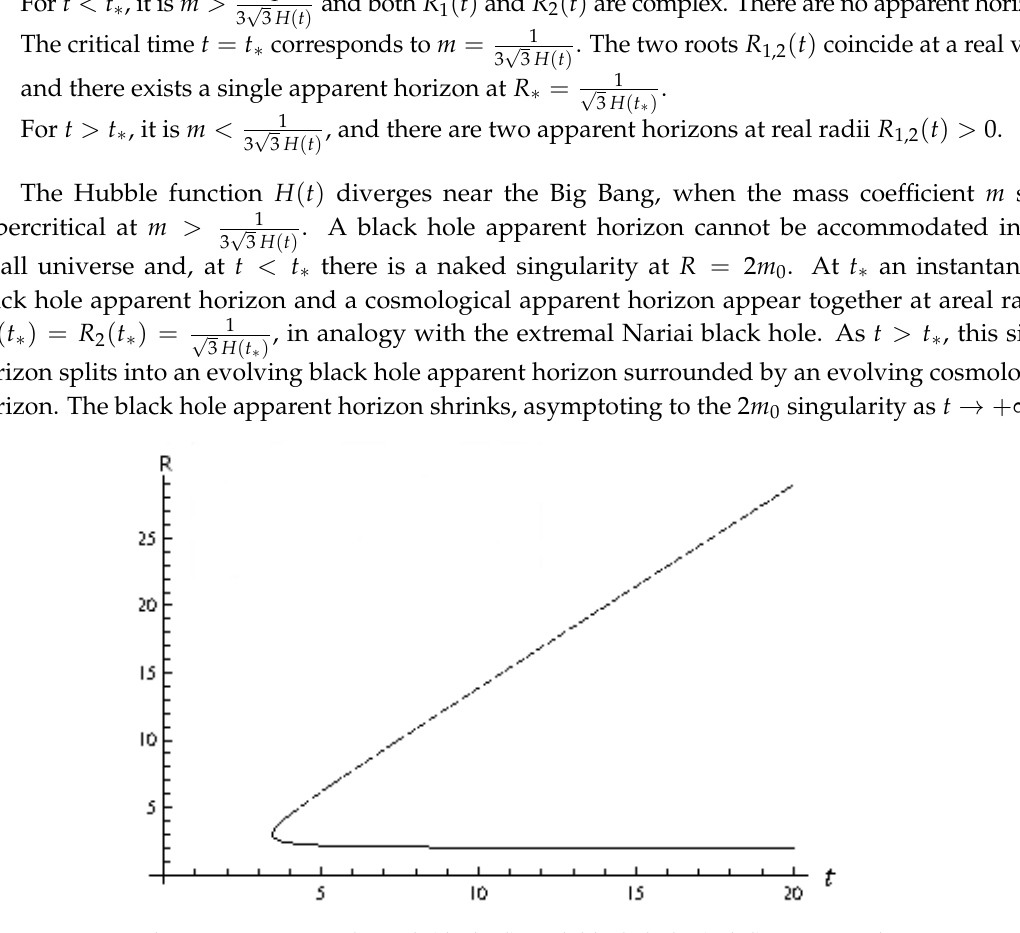
Figure 1. The McVittie cosmological (dashed) and black hole (solid) apparent horizons in a dust-dominated “background” universe. Time t and radius R are in units of m